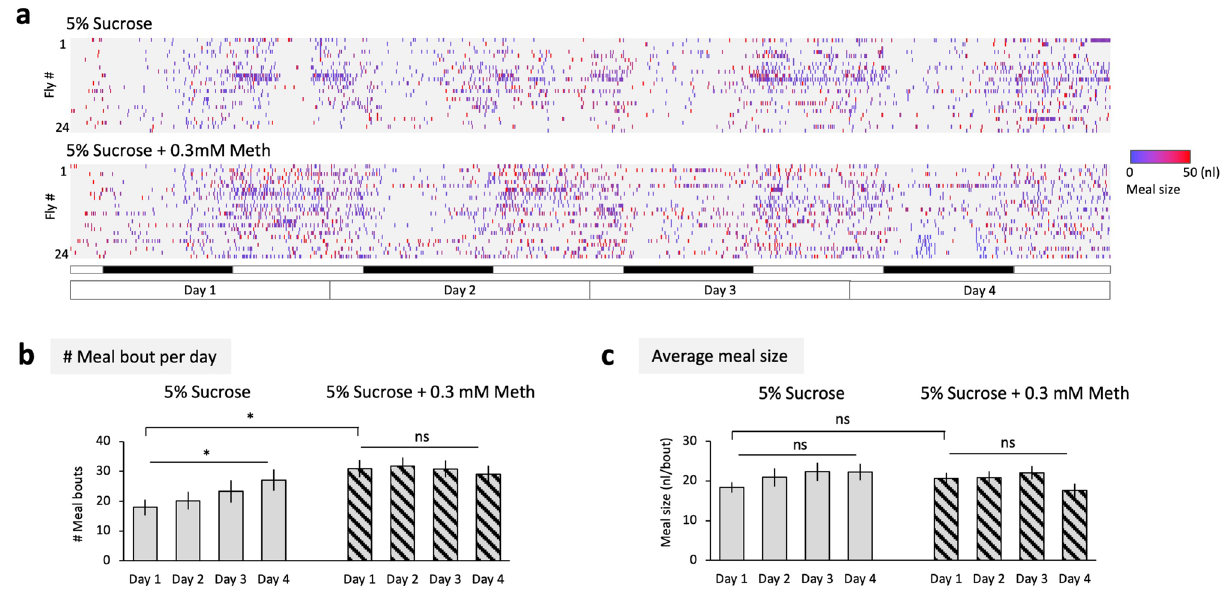
Figure 3. Repeated intake of methamphetamine. ( a ) Raster plots of meal-bouts of 5% sucrose solution (upper) and 5% sucrose supplemented with 0.3 mM methamphetamine (lower). This dose is chosen because both 0.1 and 1 mM methamphetamine elicit the drug preference (see Fig. 1b). Meal events and the size are measured and shown in a similar manner to the Fig. 2. ( b ) The number of detected meal bouts per day. 5% sucrose: P = 0.0273, n = 24 (Friedman test); 5% sucrose + 0.3 mM methamphetamine: P = 0.7756, n = 24 (Friedman test). 5% sucrose vs 5% sucrose + 0.3 mM methamphetamine on day1: P = 0.0047, n = 24 (Wilcoxon test). ( c ) (1.648, 37.89) = 2.547, P = 0.1008, n = 24 (one-way repeated-measures ANOVA). 5% sucrose vs 5% sucrose + 0.3 mM methamphetamine on the day 1: P = 0.2076, n = 24 (Wilcoxon test). Bar graphs: mean ± SEM. *: P <